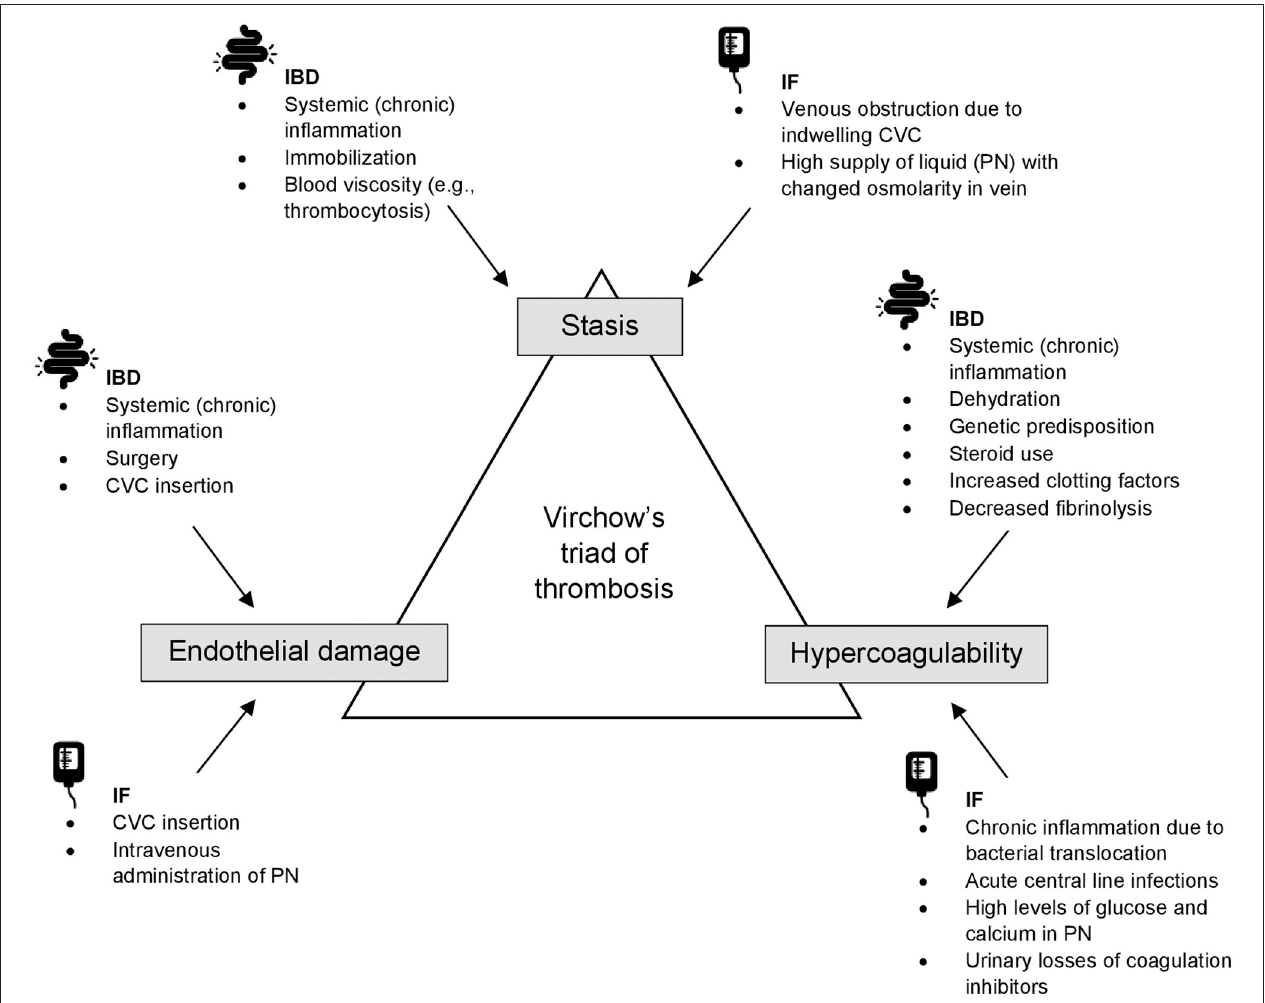
FIGURE 1 | An overview of Virchow’s triad of thrombosis in IBD and IF. CVC, central venous catheter; IBD, inflammatory bowel disease; IF, intestinal failure; PN, parenteral nutrition.